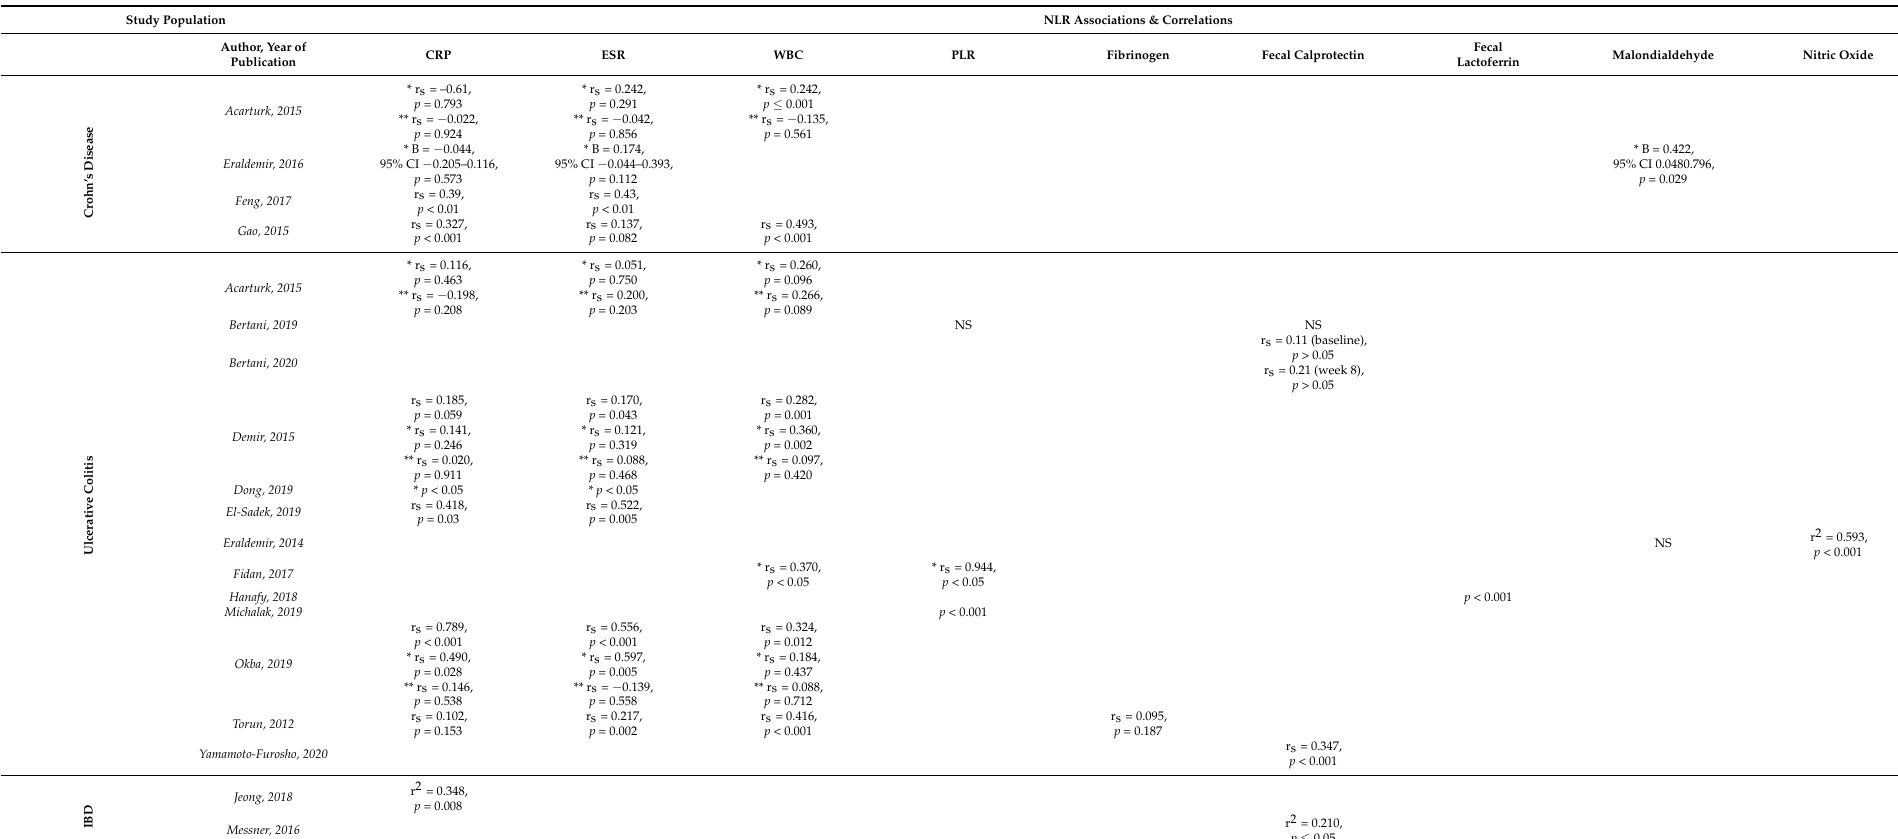
Table 3. Association of NLR with other IBD